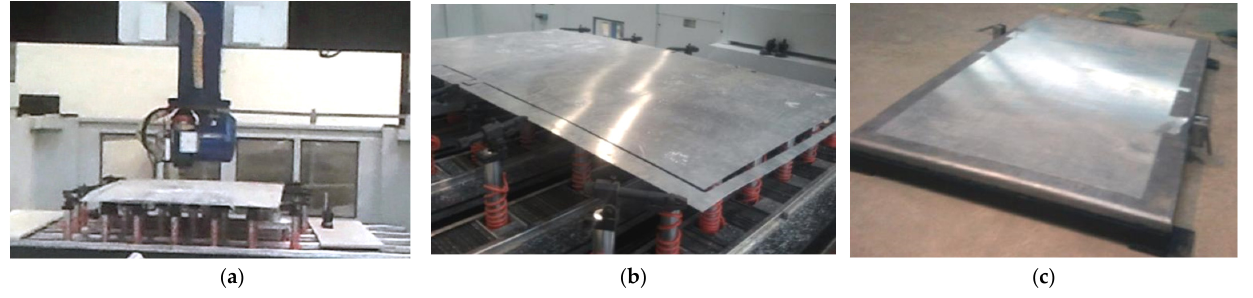
Figure 7. Trimming experiment of large-size aircraft skin: ( a ) in-operation; ( b ) end of trimming; ( c ) contour accuracy